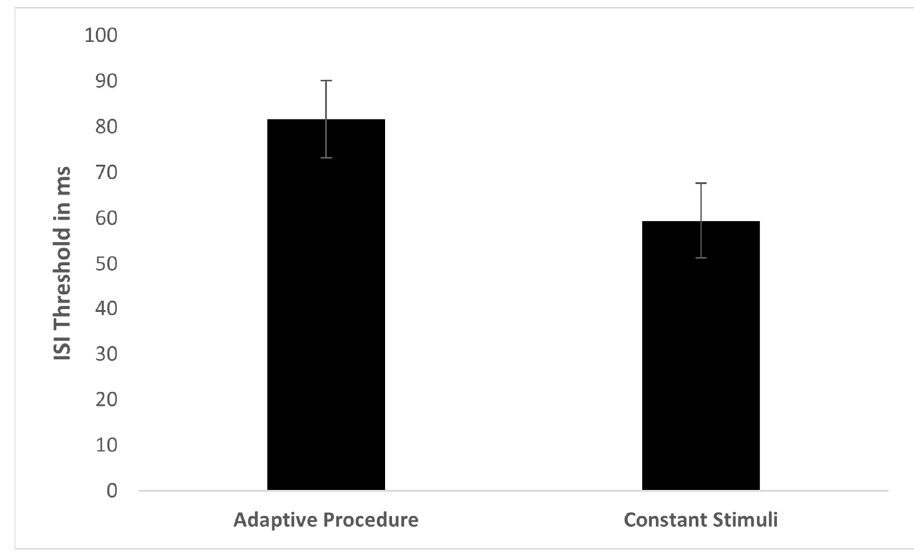
Figure 4. Mean and standard error for spectral TOJ thresholds in adaptive procedure and method of constant stimuli.